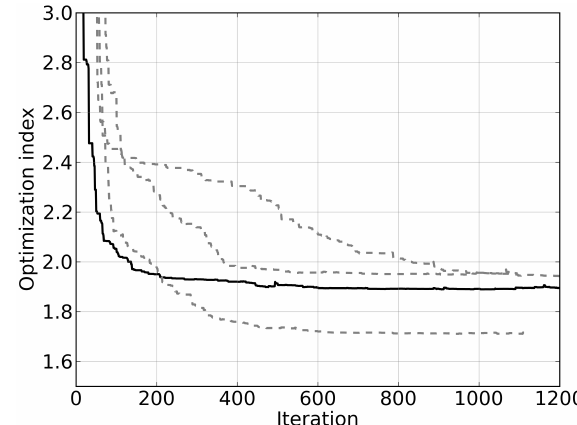
Figure 3. HESFIRE’s performance through the optimization pro- cedure iterations. The solid line represents the optimization of the final model. The dashed lines represent the optimization of three of the alternative runs, using different sets of grid cells and years to evaluate the robustness of the